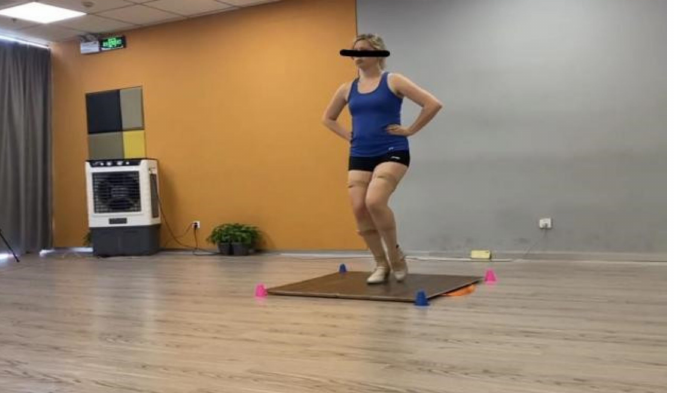
Figure 1. Akimbo posture required for completing the footwork